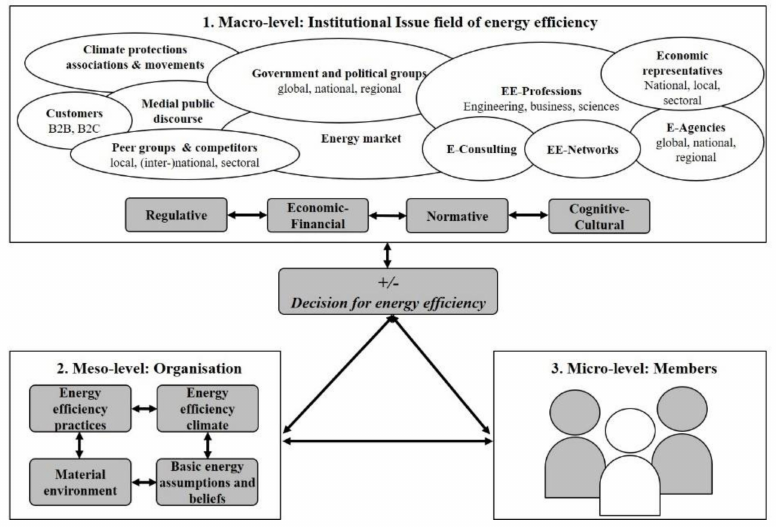
Figure 1. Energy e ffi ciency culture framework following König